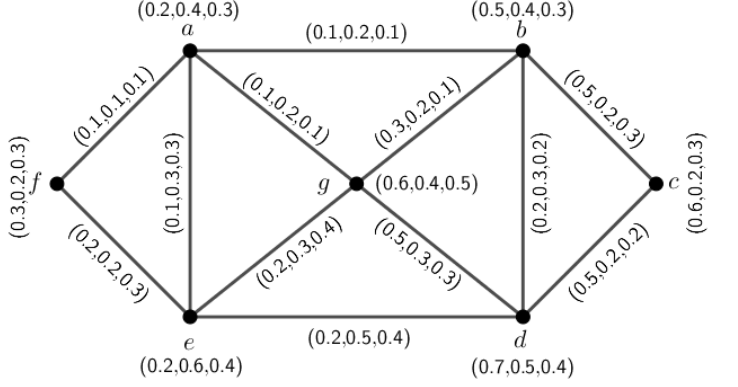
Figure 5. Domination integrity of 3PFG G .